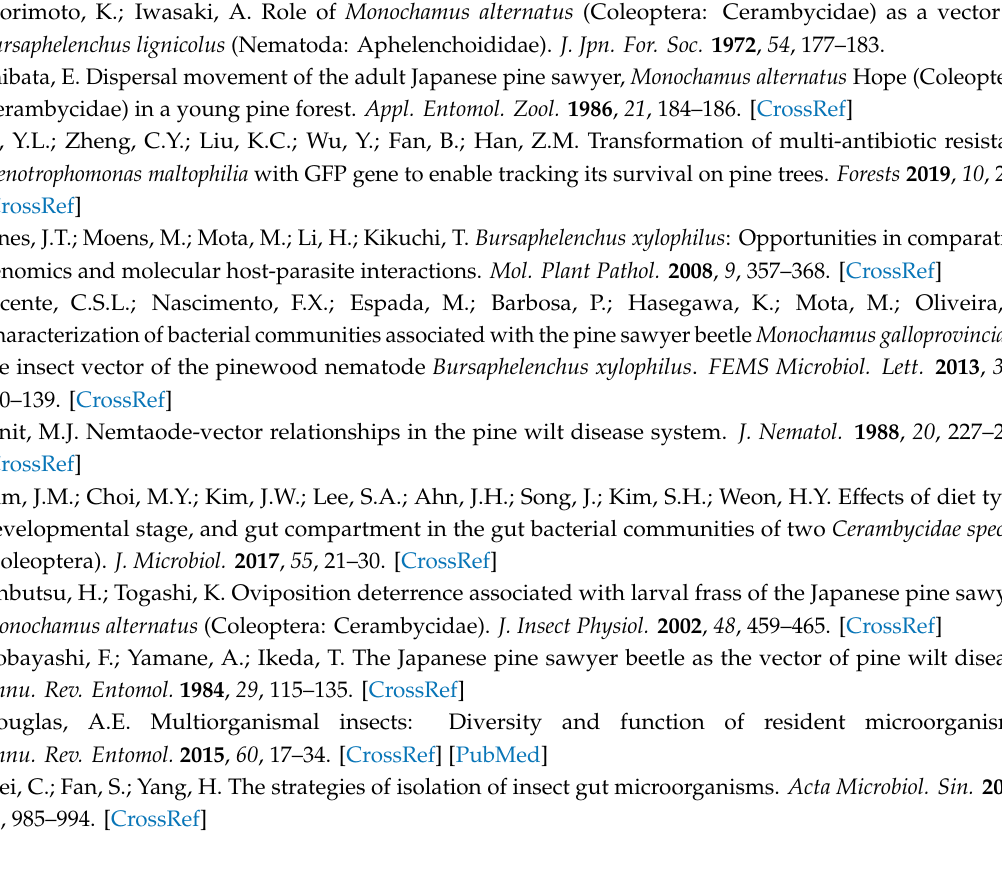
Figure S1: Community analysis pieplot on genus level of larval guts, Figure S2: Community analysis pieplot on genus level of pupal guts, Figure S3: Community analysis pieplot on genus level of pupal chamber tissues, and larval gallery tissues, Figure S4: KEGG pathway of Starch and Sucrose Metabolism mapped by intestinal samples, Figure S5: KEGG pathway of Starch and Sucrose Metabolism mapped by host tissue samples, Figure S6: KEGG pathway of Limonene and Pinene Degradation mapped by host tissue samples, Figure S7: KEGG pathway of Limonene and Pinene Degradation mapped by host tissue samples, Table S1: OTU species classification statistics, Table S2: Pvalue and FDR value of Chao, and Simpson indices, Table S3: KEGG pathway level 3 abundance of each